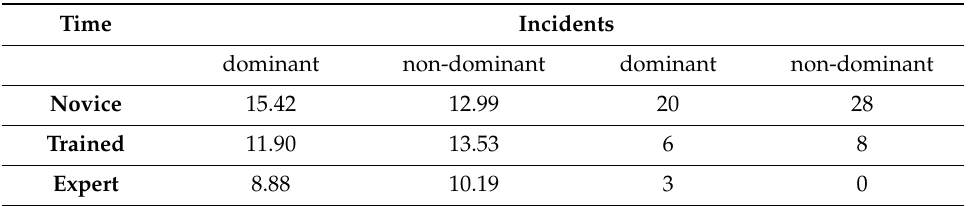
Table 1. Average task completion time (in seconds) and cumulated number of incidents as a function of expertise levels and hand for ten repeated task sessions per